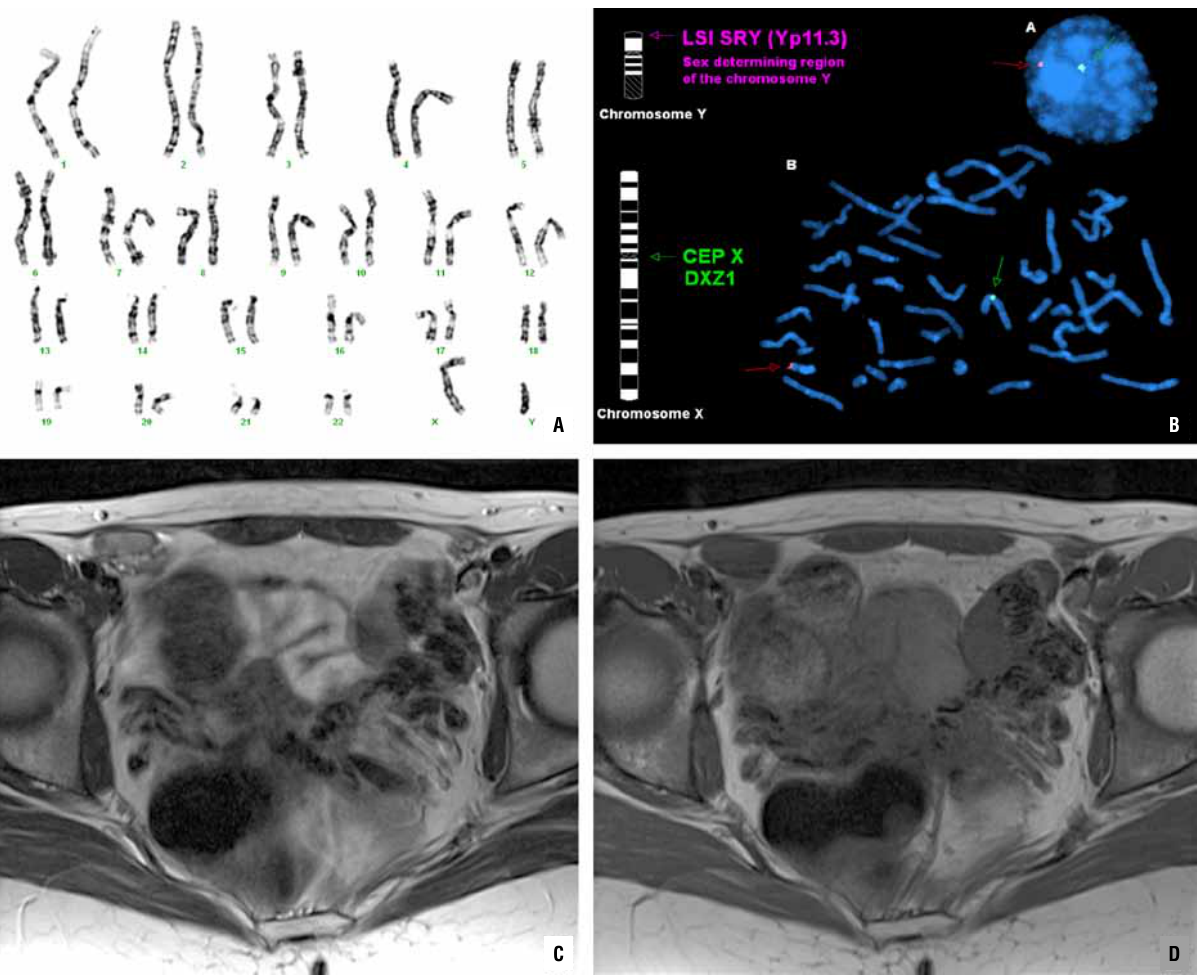
Figure 1 - Preoperative work-up: Chromosomal study with 46-Xy karyotype (A); FISH using Vysis Probe (Izasa) revealed SRy (yp11.3) and AR (Xq11-12) genes (B); Pelvic gonads on MRI of altered signal on T2 TSE (C) and homogeneous contour on T1 SE